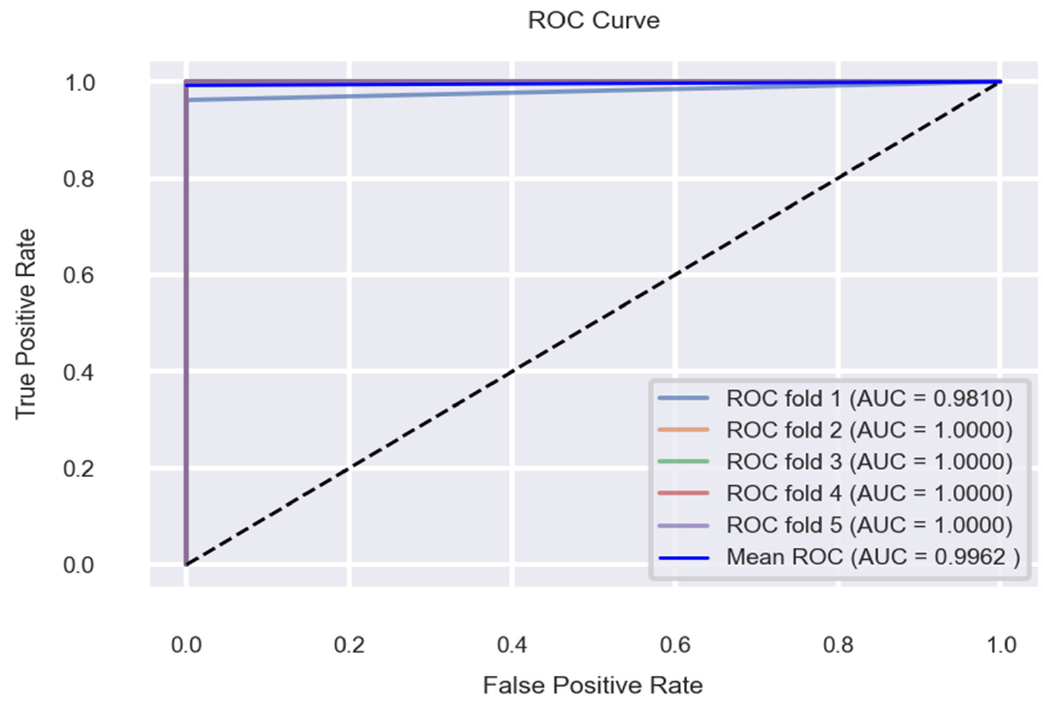
Figure 19. Stratified (K = 5)-Fold Cross-validation Results for Decision Tree Classifier (ROC-AUC).